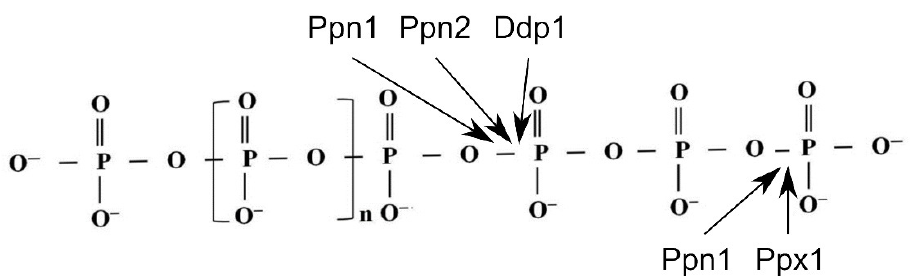
Figure 1. Schematic representation of the action of polyphosphatases on polyP. Exopolyphospha- tase Ppx1 cleave Pi from the end of the polyP chain. Endopolyphosphatases Ppn2 and Ddp1 split long-chained polyP into shorter ones. Polyphosphatase Ppn1 displays both exo- and endopolyphos- phatase activities.